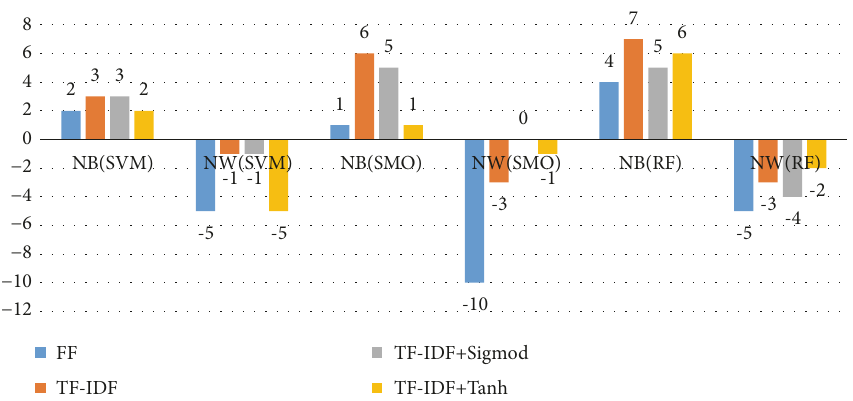
Figure 4: Best and worst number of activity concerning on precision concerning on